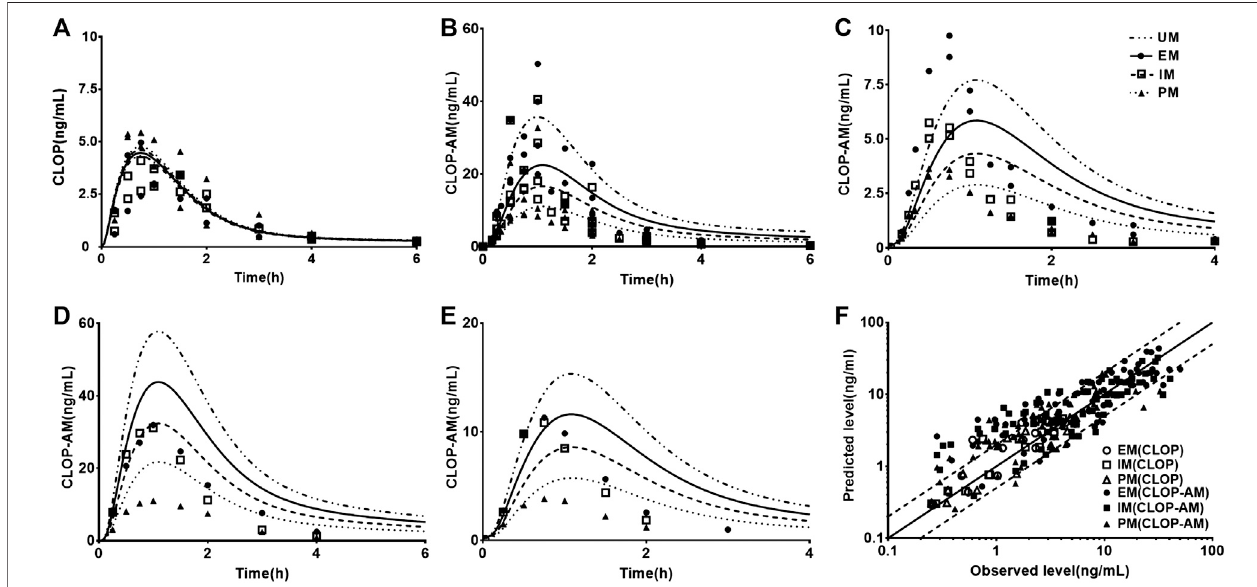
FIGURE 2 | The predicted (line) and observed (point) plasma concentration-time pro fi les in healthy volunteers. (A) CLOP concentrations after 300 mg single dose. The observations were from Kim (2014, EM n (cid:1) 7, IM n (cid:1) 8, PM n (cid:1) 7) (Kim et al., 2014) and Song (EM n (cid:1) 8, IM n (cid:1) 10, PM n (cid:1) 2) (Song et al., 2018). (B) CLOP-AM concentrationsafter300 mgsingledose; (C) CLOP-AMafter300 mgloadingdosefollowedby75 mgmaintenancedoseond7.Theobservationswerecitedcamefrom Kobayashi(EM n (cid:1) 9,IM n (cid:1) 9,PM n (cid:1) 9)(Kobayashietal.,2015),Song(EM n (cid:1) 8,IM n (cid:1) 10,PM n (cid:1) 2)(Songetal.,2018),Umemura(EM n (cid:1) 8,IM n (cid:1) 21,PM n (cid:1) 7) (UmemuraandIwaki,2016)andZhang(EM n (cid:1) 16,IM n (cid:1) 16,PM n (cid:1) 16)(Zhangetal.,2020). (D) CLOP-AMconcentrationsafter600 mgsingledose;and (E) CLOP-AM after600 mgloadingdosefollowedby150 mgmaintenancedoseond7.TheobserveddatawerefromKobayashi(EM n (cid:1) 9,IM n (cid:1) 9,PM n (cid:1)